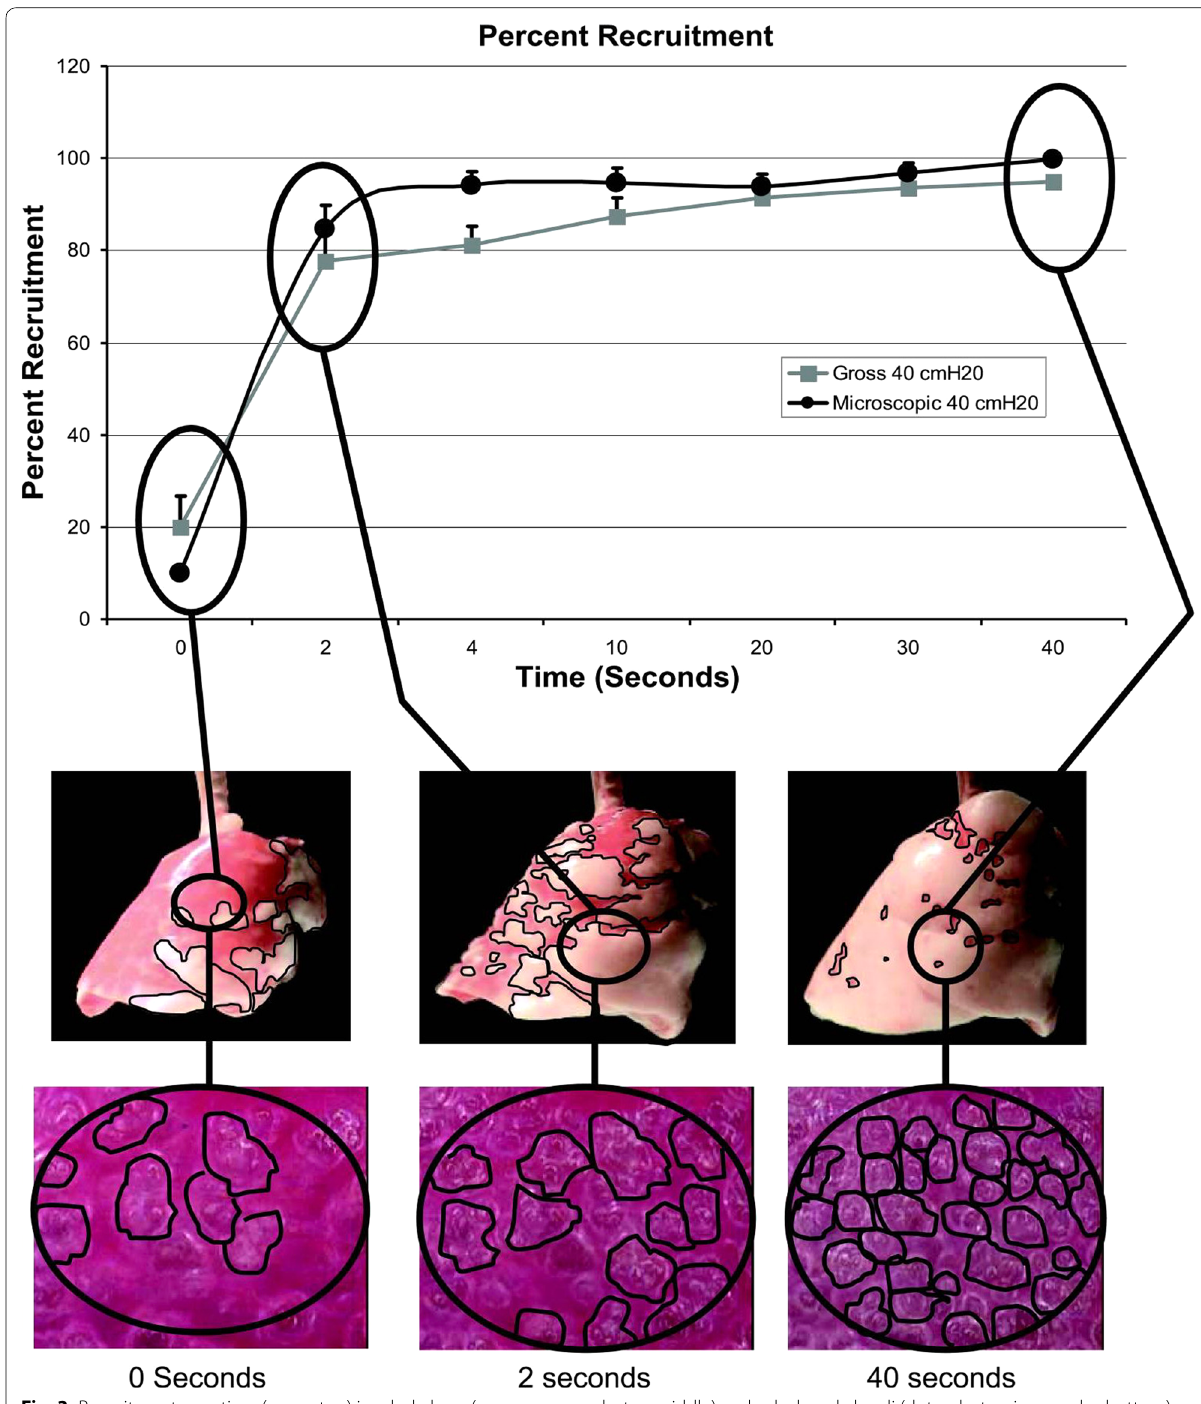
Fig. 3 Recruitment over time (curve, top) in whole lung (squares, gross photos, middle) and subpleural alveoli (dots, photomicrographs, bottom) driven by 40 cmH 2 O airway pressure for 40 s [70]. Whole lung and alveoli continue to recruit over time while the pressure remains constant (viscoelastic